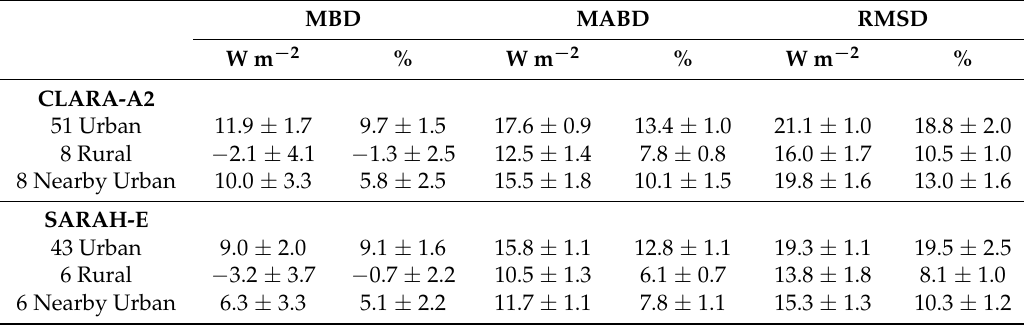
Table 3. Urbanization effects on the CLARA-A2 and SARAH-E validation results. MBD: mean bias deviation; MABD: mean absolute bias deviation; RMSD: root mean square